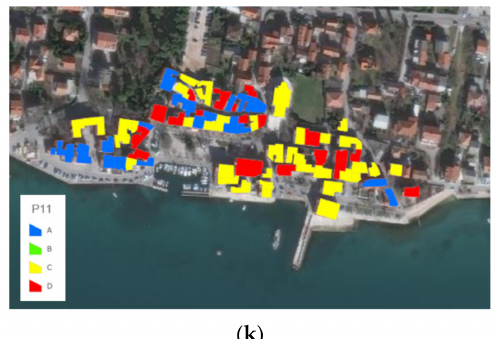
Figure 9. Spatial distribution of the 11 parameters that comprise the seismic vulnerability index: ( a ) type and organization of the resistant system; ( b ) quality of the resistant system; ( c ) conventional resistance; ( d ) position of the building and foundation; ( e ) typology of floors; ( f ) planimetric configuration; ( g ) elevation configuration; ( h ) maximum distance among walls; ( i ) roof; ( j ) non-structural elements; ( k ) state of